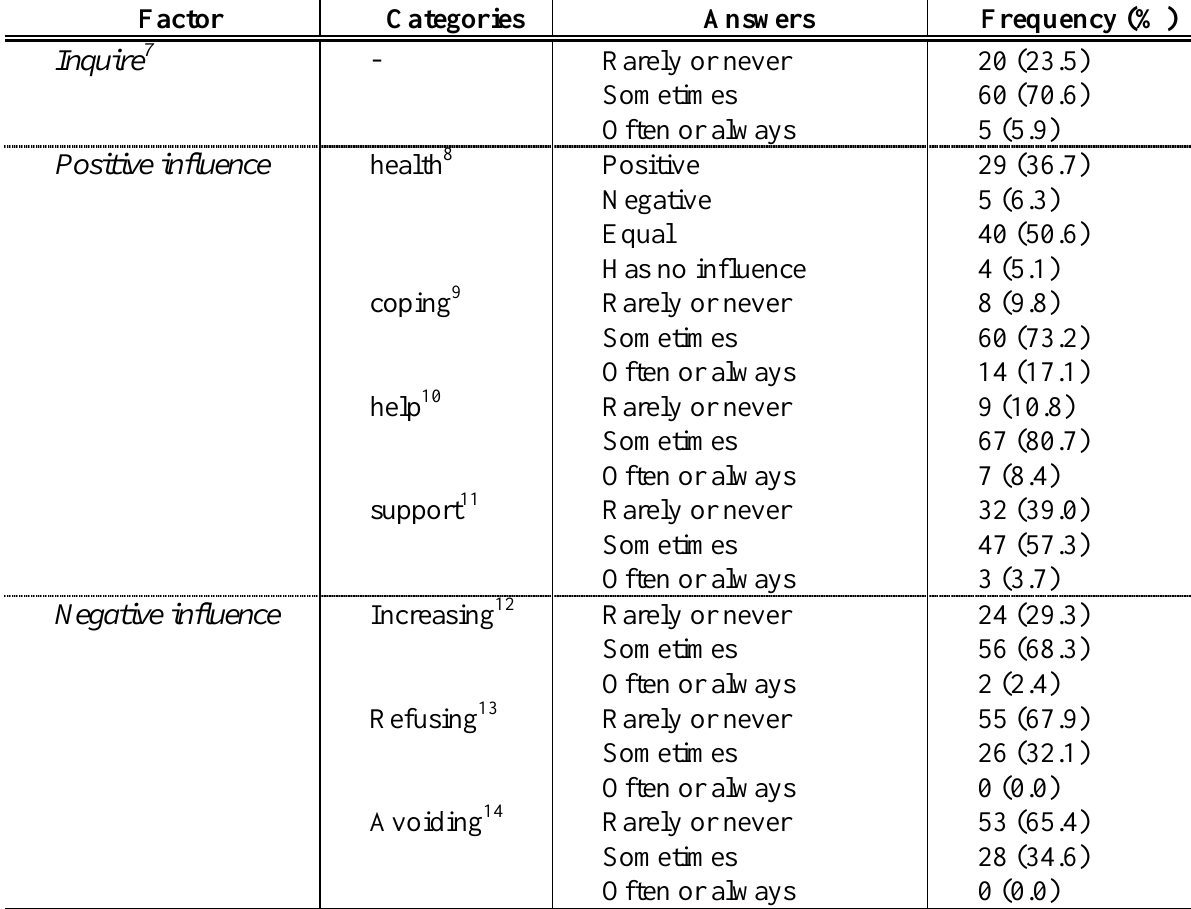
Table 3. Staff‟s attitude towards patients‟ religiosity/spirituality ( N =